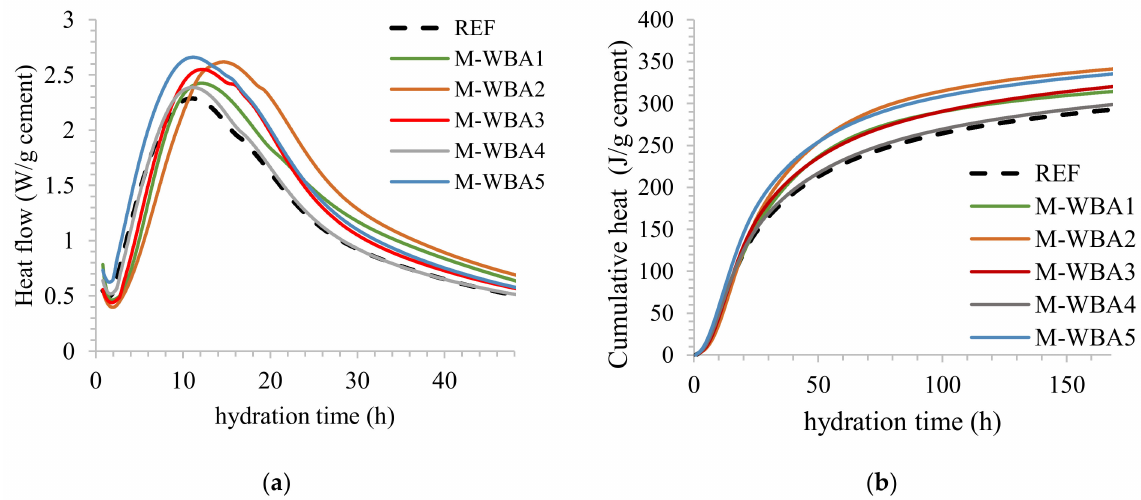
Figure 9. The influence of WBA after 1 year on the reactivity of pastes: ( a ) heat flow; ( b ) cumulative heat flow (the data are available in Supplementary